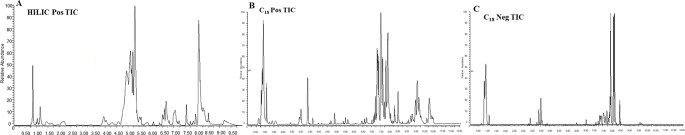
Typical TIC of the rat plasma obtained in ESI positive and negative mode based on HILIC-MS and RPLC-MS. (A) HILIC-MS TIC in positive mode; (B) RPLC-MS TIC in positive mode; (C) RPLC-MS TIC in negative mode.